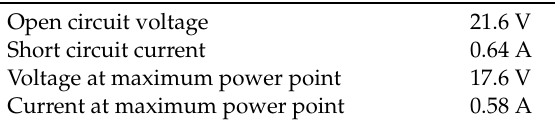
Table 2. PV module specifications.